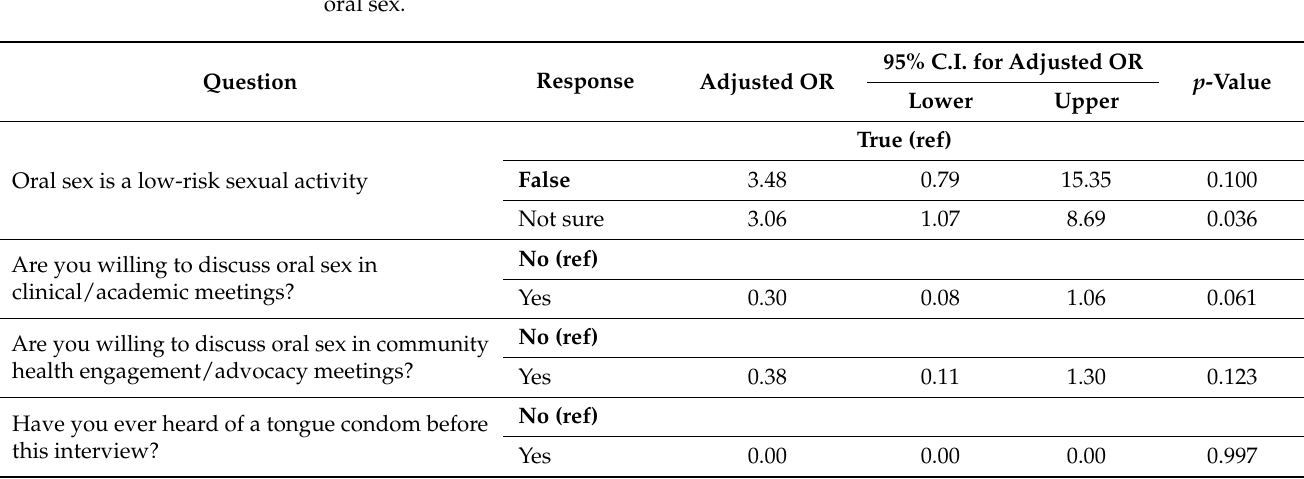
Table 7. Predictors of the respondents’ willingness to recommend protection for patients engaging in oral